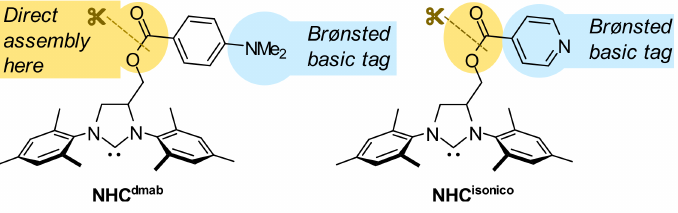
Figure 2. Planned new tagged NHC ligands bearing basic Brønsted